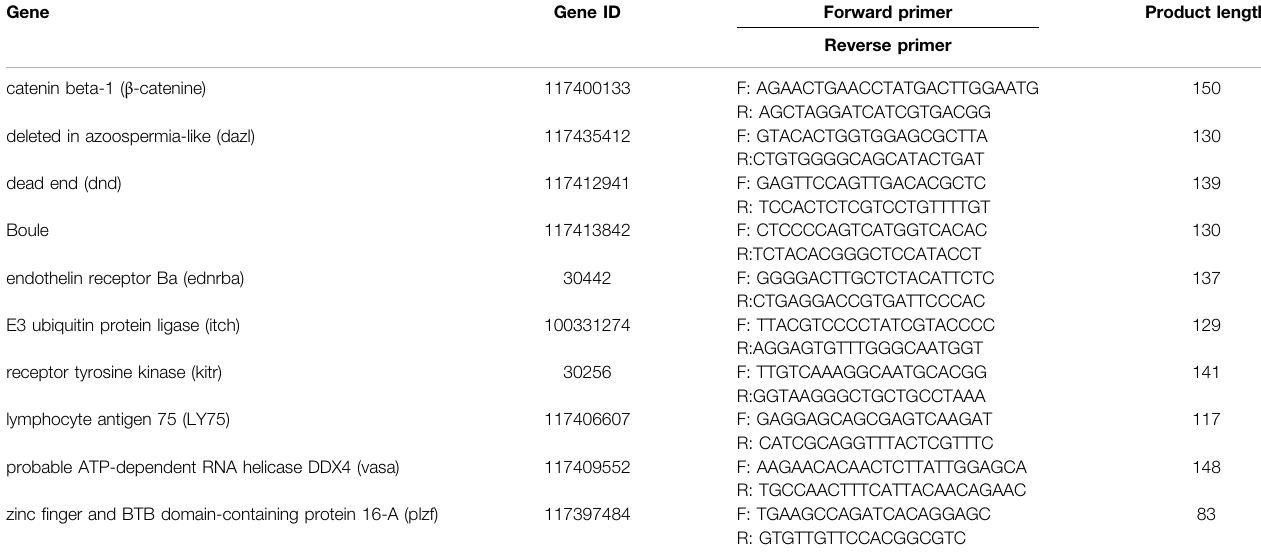
TABLE 1 | Primers for detection of mRNA in sorted cells. Gene Gene